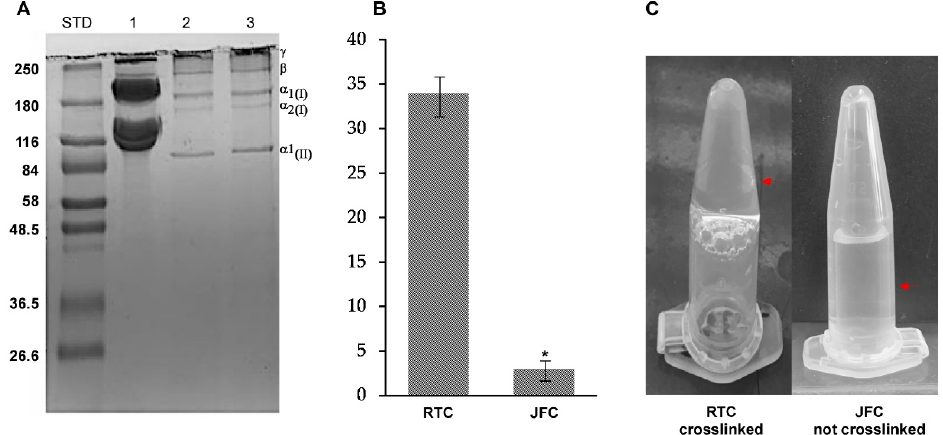
Figure 1. Acid-soluble proteins extracted from R. pulmo and comparison of the mammalian collagen from rat tail (RTC) and jellyfish collagen from R. pulmo (jellyfish collagen (JFC)). ( A ) SDS-PAGE analyses of rat tail type I collagen (20 µ g; Line 1); R. pulmo oral arms collagen (20 µ g; Line 2); R. pulmo umbrella collagen (20 µ g; Line 3). STD represents molecular weight markers in kDa. ( B ) Analysis of cross-linking degree. Bars represent mean ± SD ( n = 3), and asterisk denotes p < 0.05. ( C ) JFC was not able to gelify, unlike the RTC which forms a very stable hydrogel in a few minutes. The arrows indicate the different positions of the collagen in each sample .